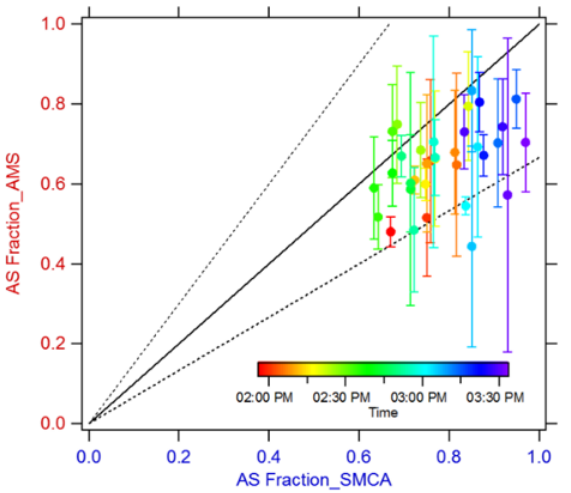
Figure 5. Plateau heights derived from AMS data vs. SMCA. Single CCNC supersaturation. Dashed lines indicate 50% uncertainty (1 : 1 . 5 and 1 . 5 : 1).